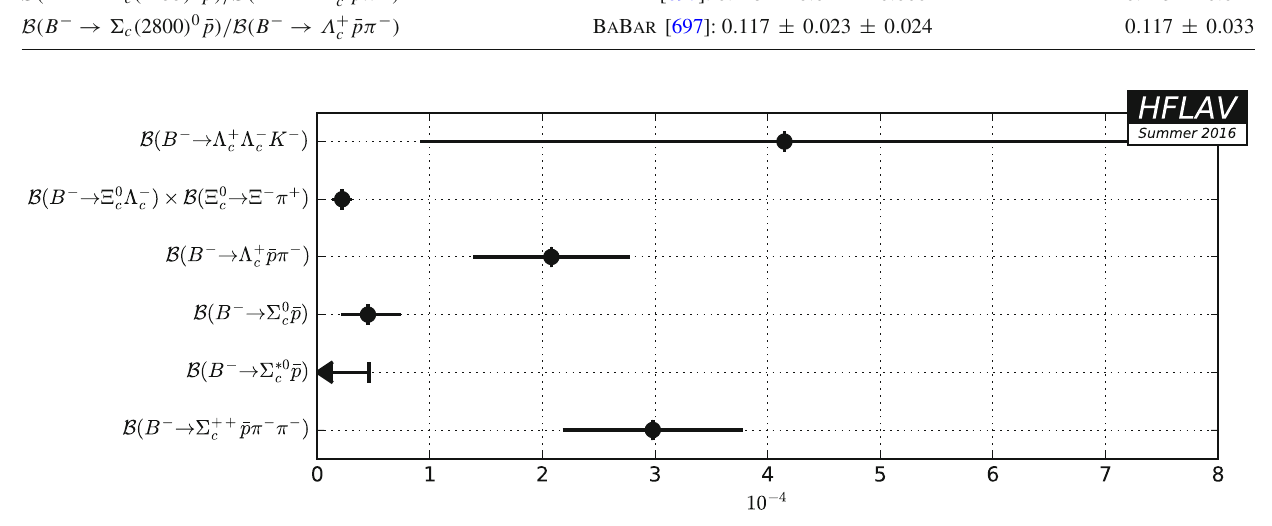
Fig. 139 Summary of the averages from Table 170